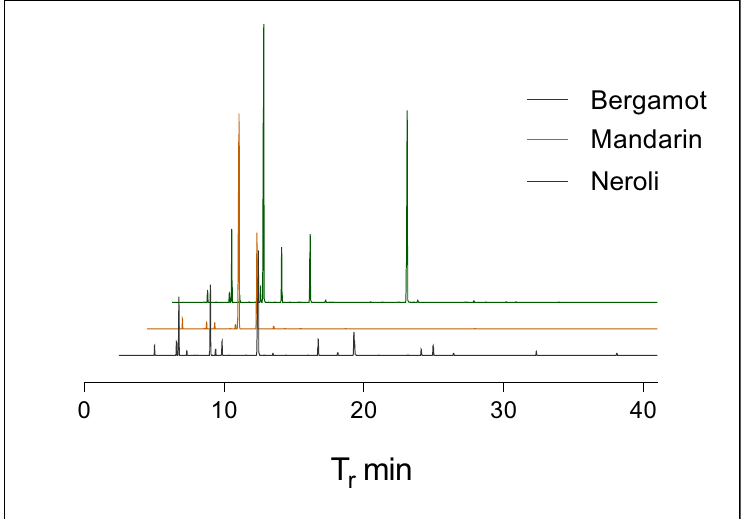
Figure 1. Examples of total ion chromatograms, offset by 1 min each, of Citrus essential oils (bergamot, mandarin, and neroli essential oils). Chemical compositions are detailed below.